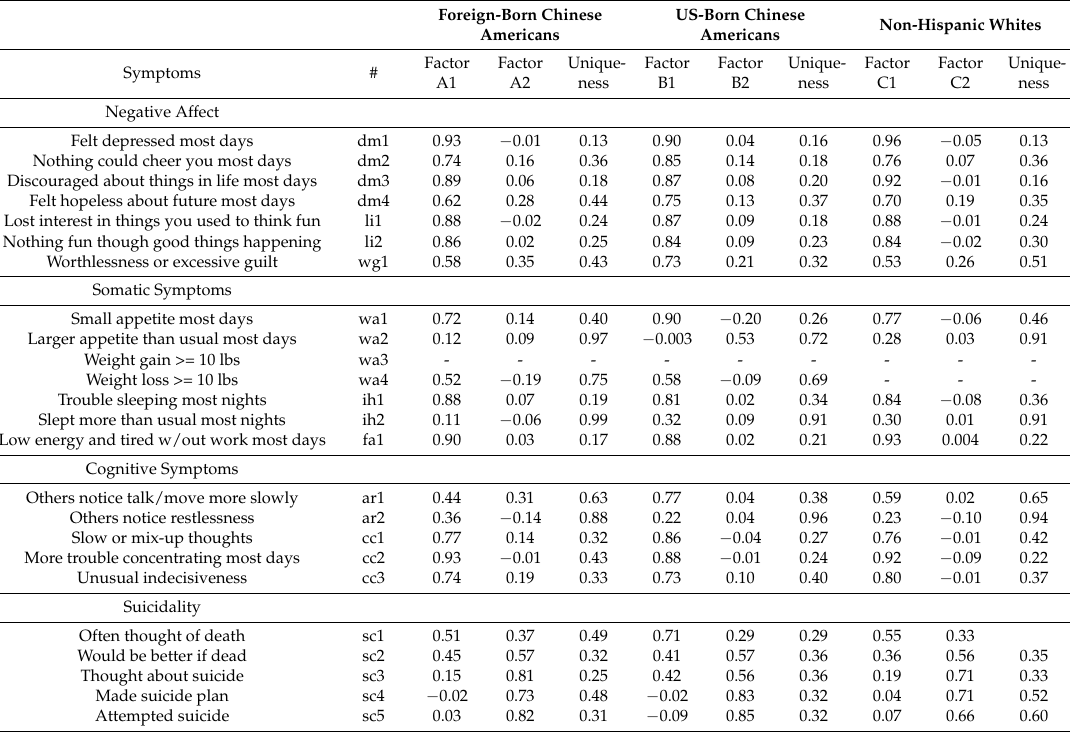
Table 4. DSM-IV MDD Symptoms Factor Analysis.